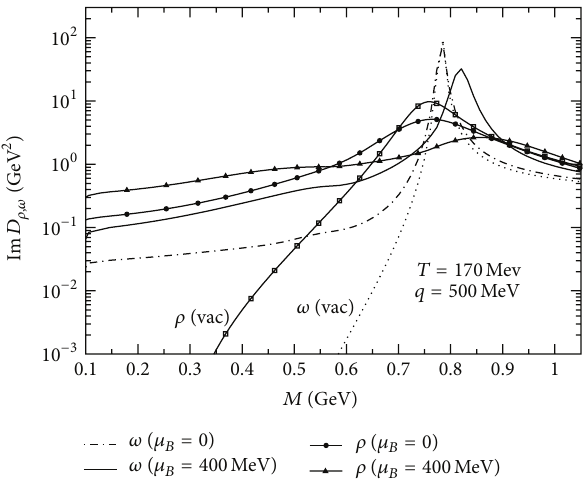
Figure 19: The 𝜔 spectral function seen in comparison with the 𝜌